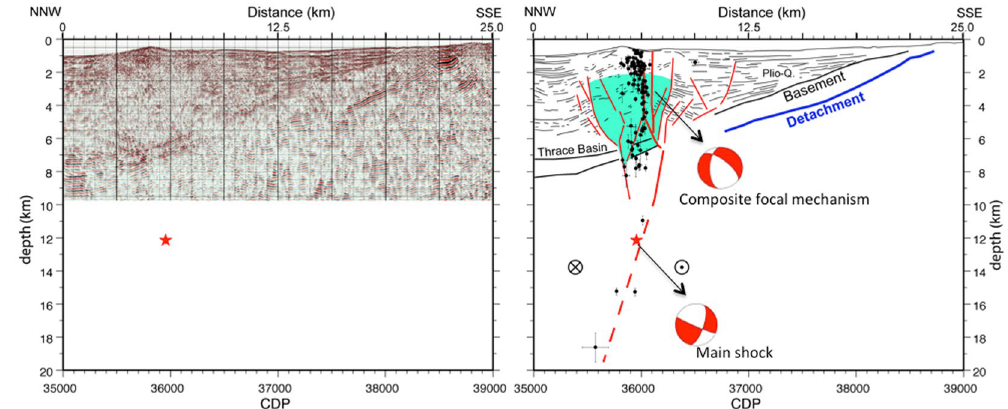
Figure 5. Left panel displays the hypocenters of the aftershock sequence, superimposed on the seismic section (see track line in Fig. 2) that was shot during the Seismamara cruise 28,36,56 in 2001 in the Western High area. The migration was obtained after stack and time-migrated, by using 5 main velocity intervals based on velocity analysis for the sedimentary layers and constraints from refraction modelling for the crust: the water- column, the shallow sediment interval, the deep sediment interval, the interval between the basement and the detachment, and the crustal layer below the detachment. Velocity in the water is settled constant at 1500 m/s and velocity increases linearly in other intervals. The average velocity in the shallow sediment is 1700 m/s, 2400 m/s for the deep sediment interval, 3300 m/s between the acoustic basement and the detachment, and is 5500 m/s in the crust below the detachment. Line-drawing (partly based on ref. 37 , page 160) is displayed in right panel along with the locations of the aftershocks that followed the M 5.1 earthquake of July, 25, 2011. Continuous red line indicates the MMF. The dotted line within the sedimentary basin indicates the east-west oriented, secondary fault displayed in Fig. 4. The earthquakes (at depths between 2 and 4 km) that were used to compute the composite focal mechanism using HASH 38,39 are listed in Appendix 3. Image created with GMT software, Version